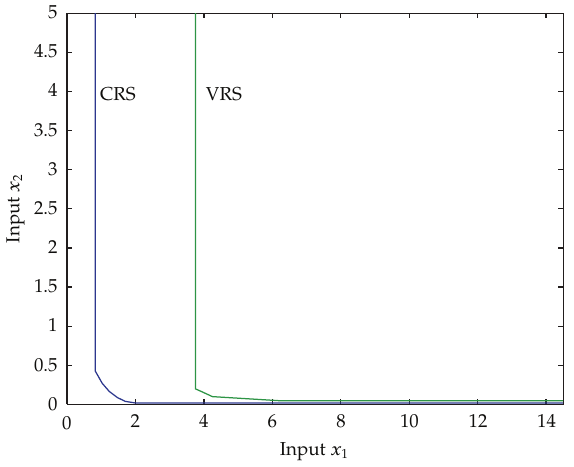
Figure 14: Input isoquants at y (cid:9) 1.